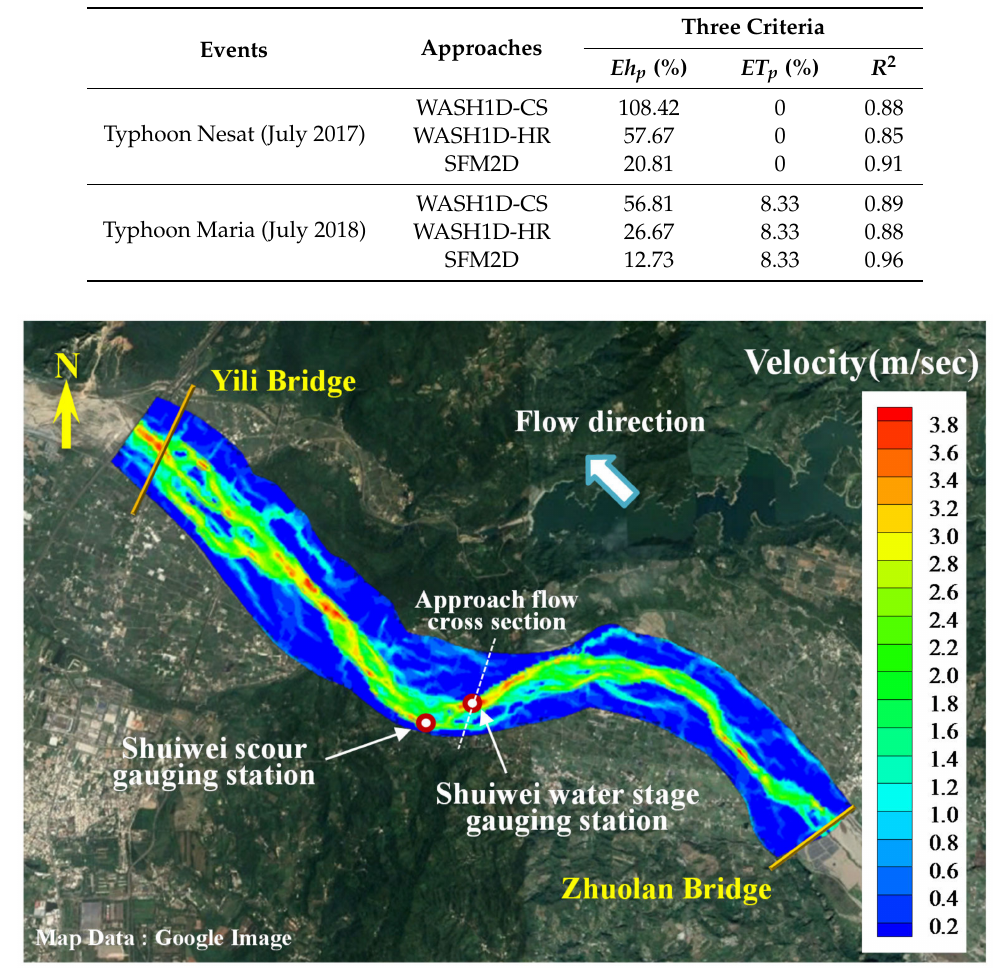
Simulated results at the Shuiwei water gauging station obtained using the three presented approaches.